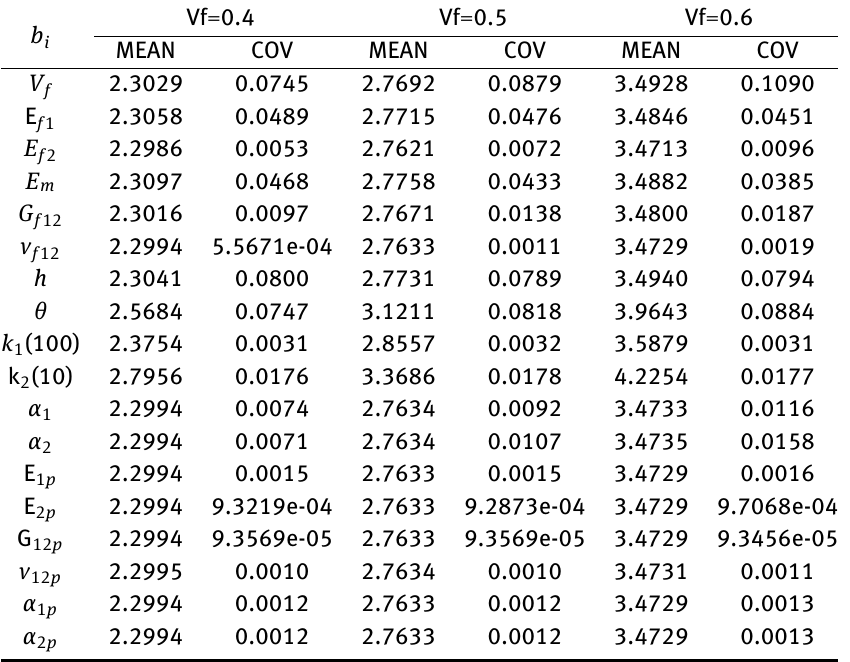
Table 2: Effects of individual random variable and fiber volume fraction on the dimensionless mean and COV of buckling temperature of laminated clamped supported square elastically supported